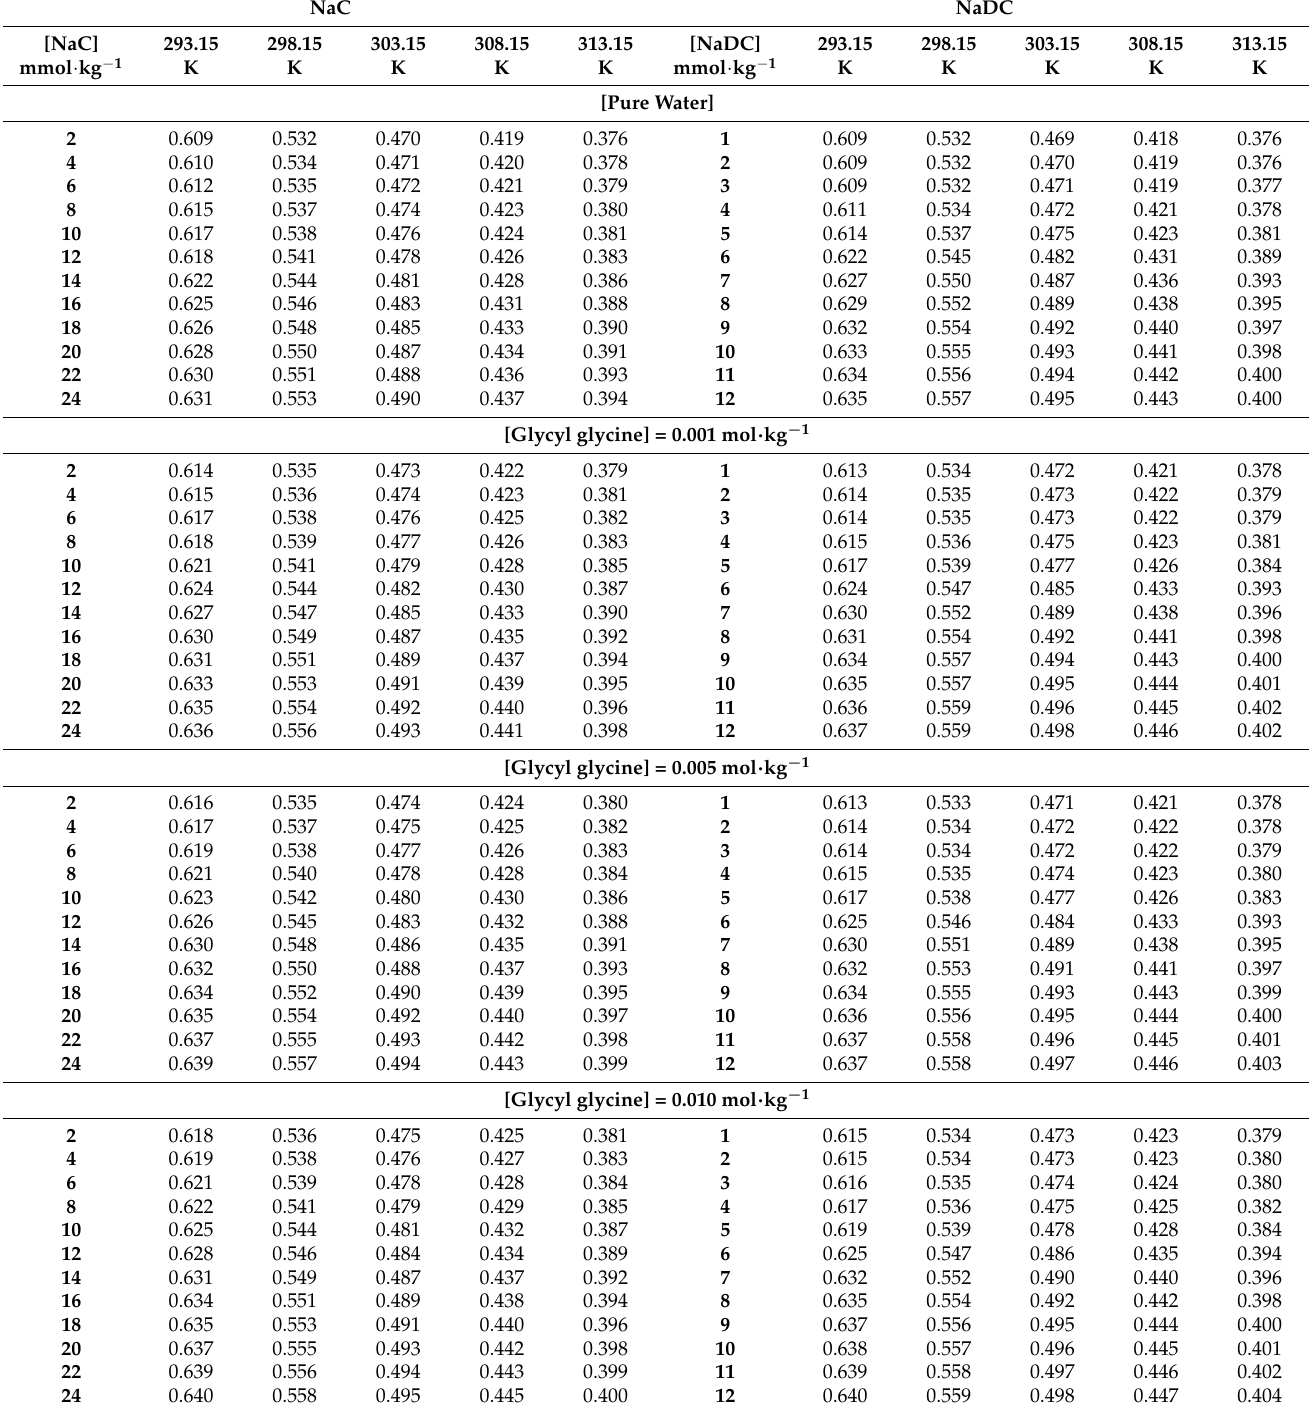
Table 5. Viscous relaxation time, τ (ps) values for NaC and NaDC in pure water and in 0.001,